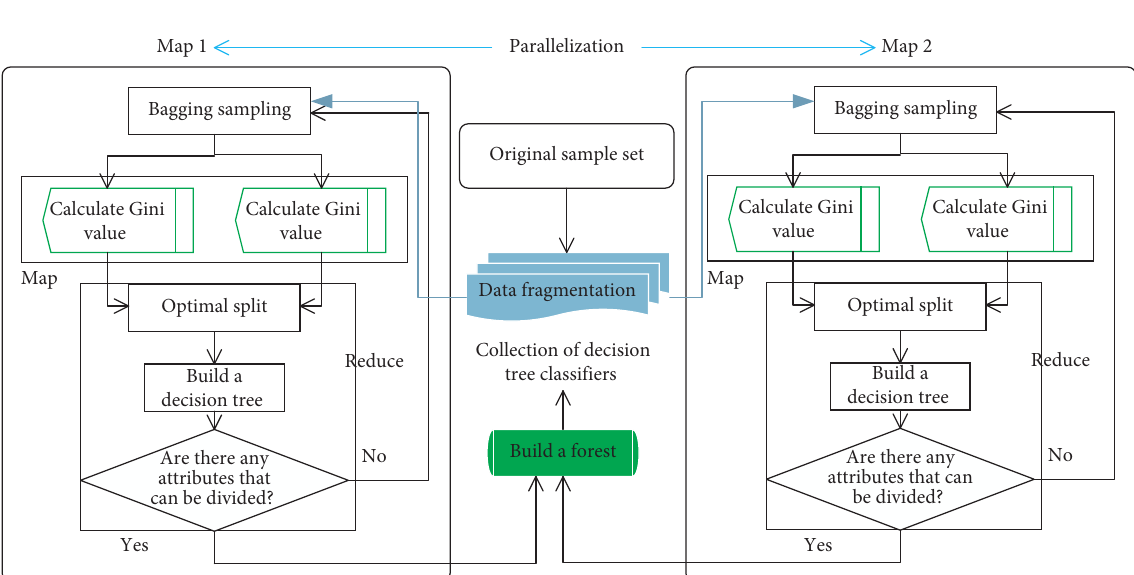
Figure 2: Random forest algorithm model.